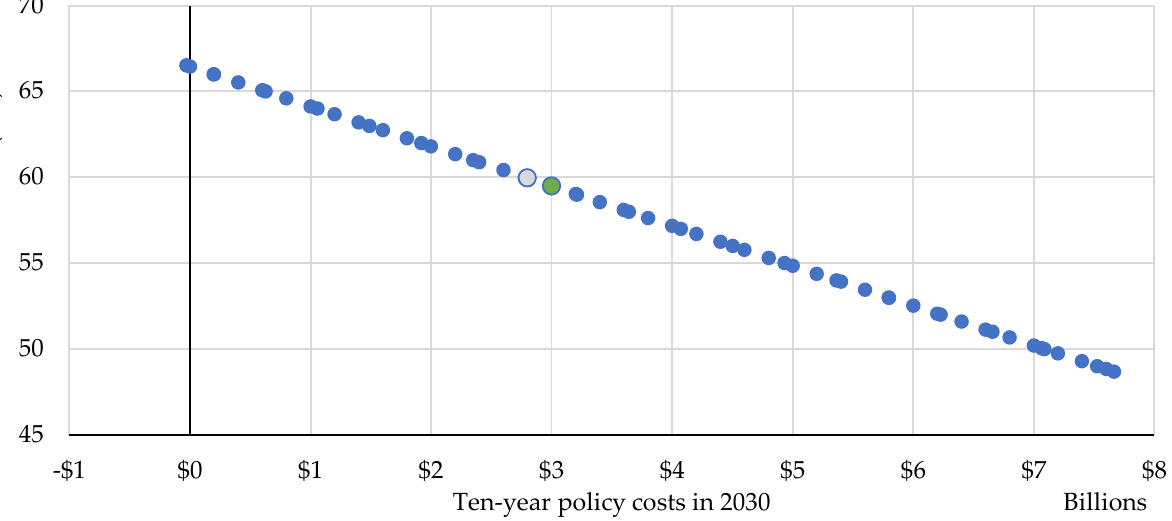
Figure A2. Pareto front 2 calculated from the MIO model. Assumes LDV fleet is 38% EV in 2030 (high-EV) and lower-bound TCO (low-TCO). Green and grey points represent the two policy sce- narios (~3$ billion ten-year policy costs in 2030 and 40% GHG reduction relative to 2005 levels in year 2030) presented in Section 4.